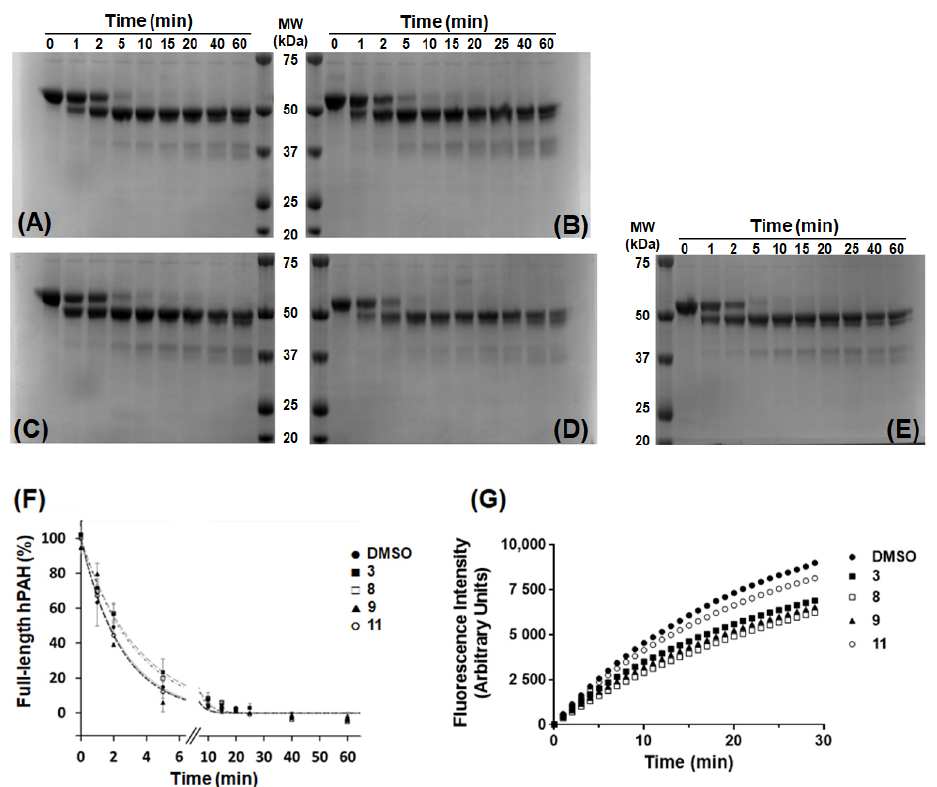
Figure 6. Effect of 3HQ derivatives on the time-course for the limited proteolysis by trypsin of human phenylalanine hydroxylase (hPAH). ( A – E ) Representative SDS-Polyacrylamide gel electrophoresis analyses of hPAH limited proteolysis by trypsin in the presence of 1% DMSO ( A ), or 100 µ M of compounds 3 ( B ), 8 ( C ), 9 ( D ) and 11 ( E ) in 1% DMSO. ( F ) Time-course of the limited proteolysis of hPAH in the presence of 1% DMSO ( • ) and 100 µ M of compounds 3 ( (cid:4) ), 8 ( (cid:3) ), 9 ( π ), and 11 ( ) in 1% DMSO; for each assay, the area at time zero was considered 100%; data represent the mean ± SEM (two independent experiments) and were fitted to a single exponential decay equation to determine the rate of proteolysis (min − 1 ). ( G ) Effect of selected 3HQ derivatives on trypsin activity using N-CBZ-GGR-AMC as the enzyme substrate; assays were performed in the presence of 1% DMSO ( • ; control), and 100 µ M of compound 3 ( (cid:4) ), 8 ( (cid:3) ), 9 ( (cid:78) ), and 11 ( ) in 1% DMSO; data represent the mean of three independent experiments; Trypsin activity was calcu- lated by determining the initial velocity of the reaction using the data points presented in the graph; relative trypsin activity (considering 100% for the control) was: 79% (compound 3 ; ), 62% (compound 8 ; ), 71% (compound 9 ; ), and 92 % (compound 11 ; ). Incubation with 100 μ M L-Phe in the presence of 1% DMSO decreased the proteolytic rate ( k P ) from 0.41 ± 0.03 to 0.15 ± 0.01 min − 1 (Figure 6A,F) in line with our previous obser-